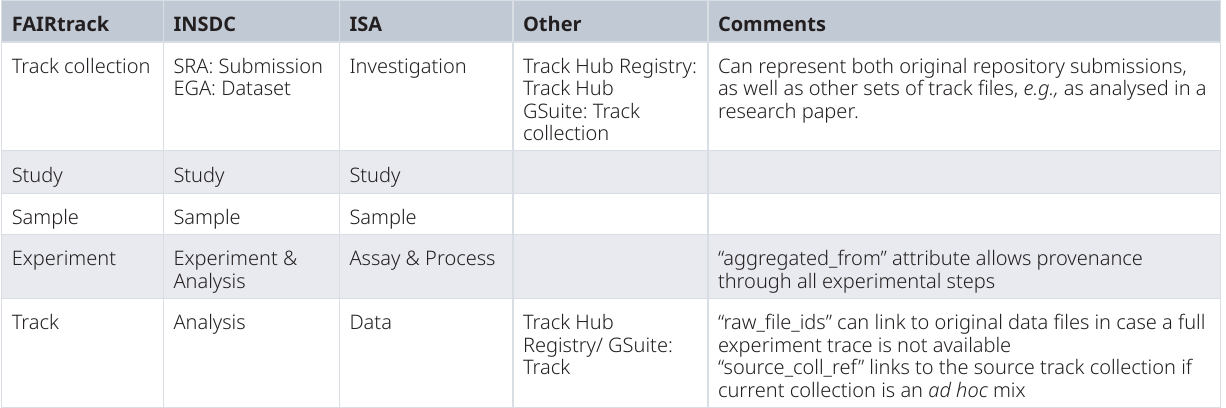
Table 3. Mapping of FAIRtracks objects to objects in other metadata